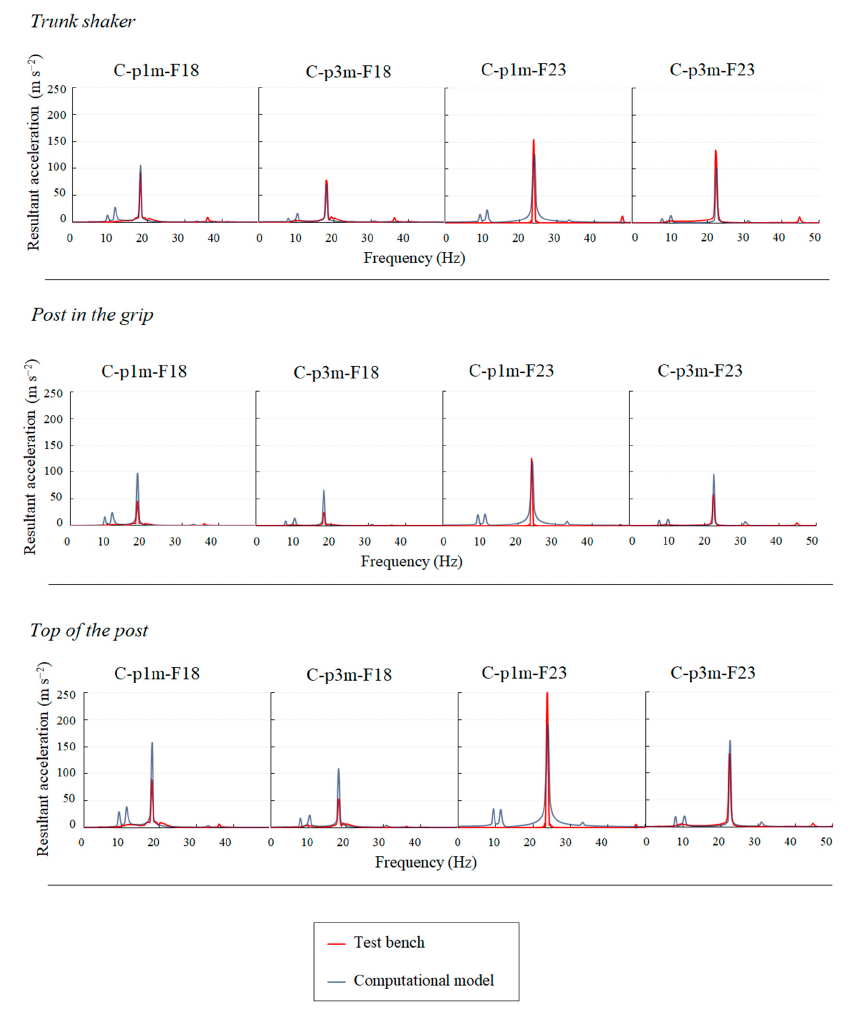
Figure 6. Vibration spectrum of the computational model and the experimental model recorded at the 3 study points.